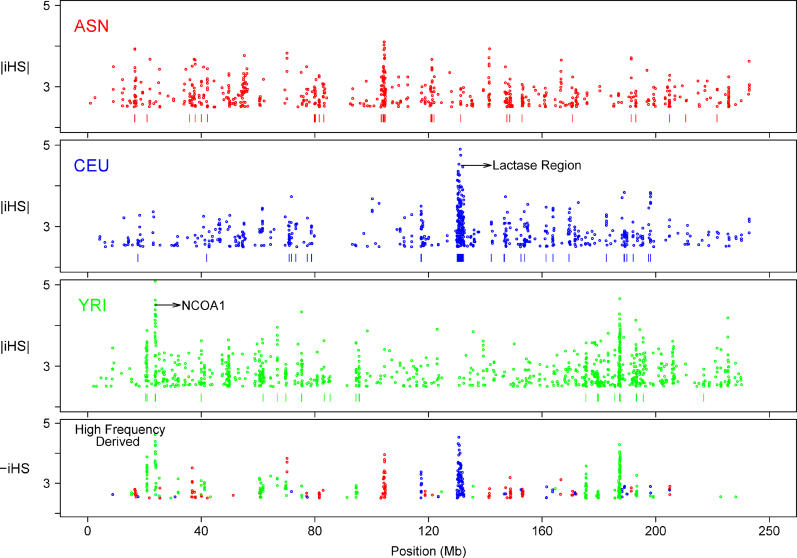
Plots of Chromosome 2 SNPs with Extreme iHS Values Indicate Discrete Clusters of SignalsSNPs with |iHS| >2.5 (top 1%) are plotted. The bottom plot combines signals for all three populations, plotting only SNPs with derived frequency >0.5 and iHS <−2.5. Such SNPs correspond to high-frequency-derived SNPs in the range for which our test is most powerful. The short vertical bars below each plot indicate 100-kb windows whose signals are in the top 1% of windows genome-wide.